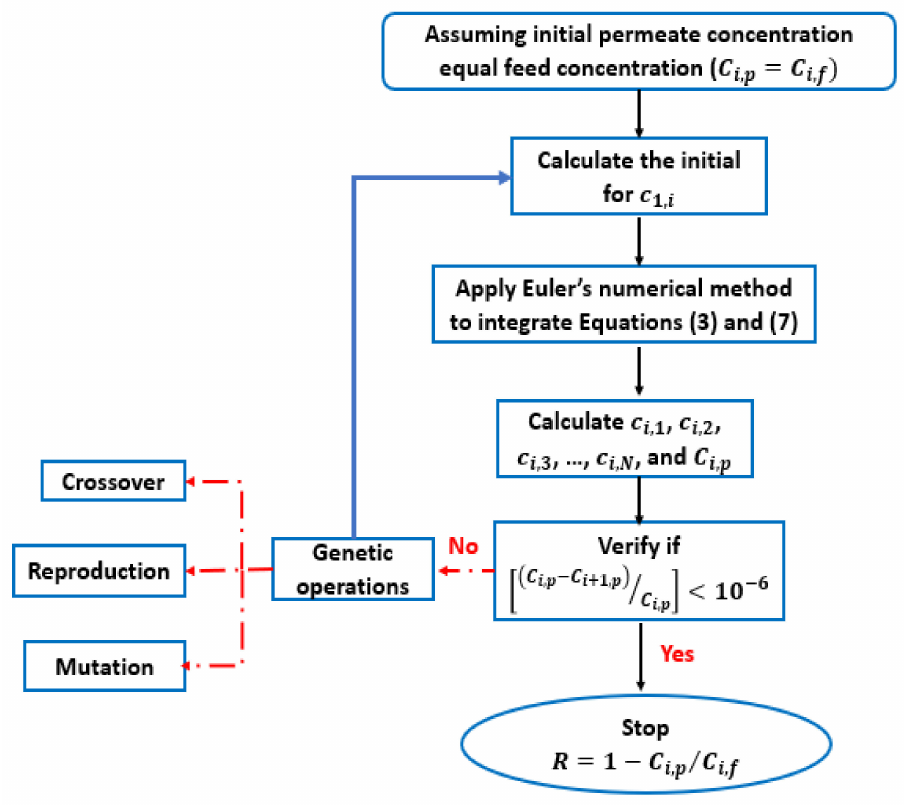
Figure 1. Flowchart describing the computation